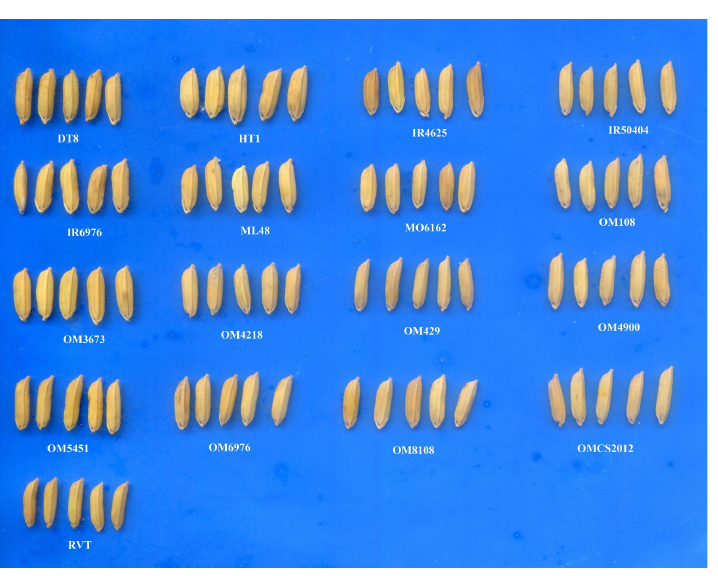
Figure 4. The 17 rice varieties samples used for classification.